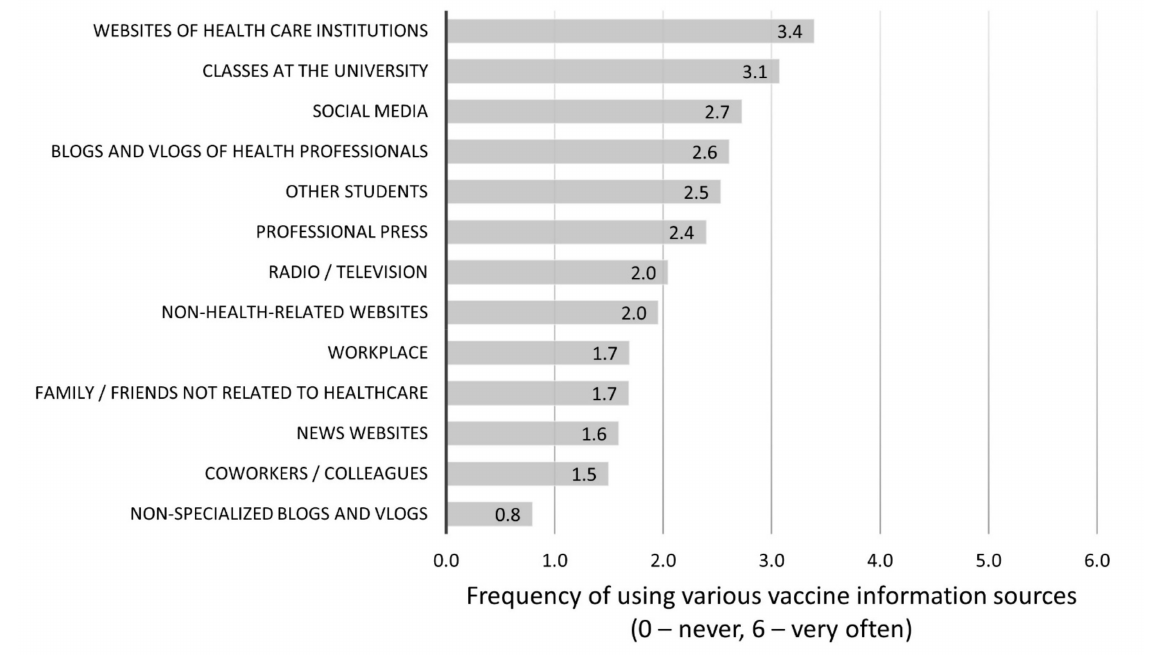
Figure 2. Average frequency of using various vaccine information sources (0—never; 6—very